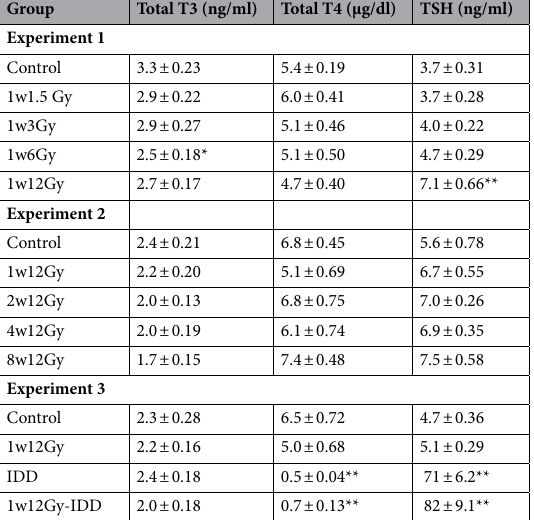
Table 3. Serum TT3, TT4 and TSH levels in rats exposed to cervical X-irradiation. *, and ** indicate significant differences from each control (* p < 0.05; ** p <